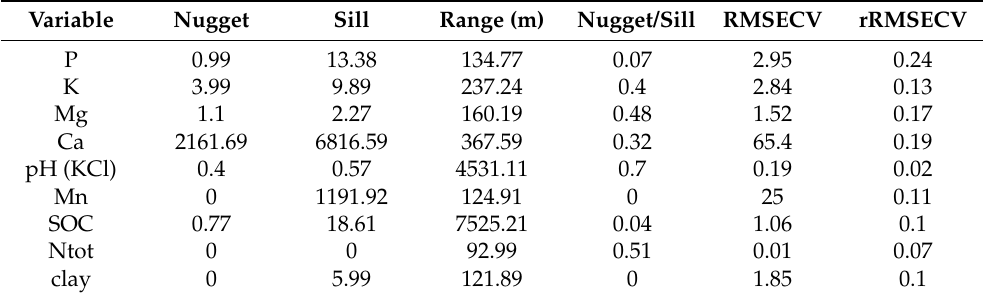
Figure 3. Pearson correlation matrix of the soil parameters from the 80 topsoil samples collected on the study field in August 2018. Ordinary kriging parameters for the soil variables selected as input for the fi- nal conditional inference forest (CI-forest) algorithm. RMSECV = RMSE of cross validation, rRMSCVE = relative